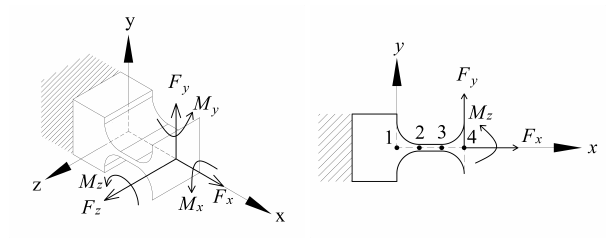
Figure 11. Deformation analysis of the corner-filleted